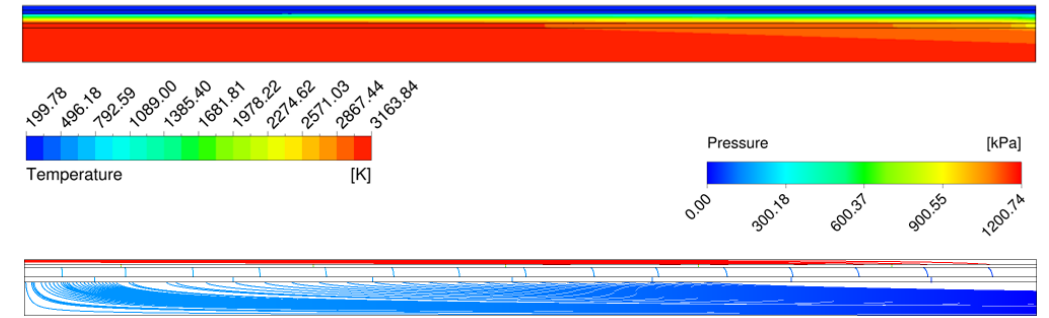
Figure 13. Temperature field, pressure profile, and streamline in a cold frit-dominated fuel element of PBR.